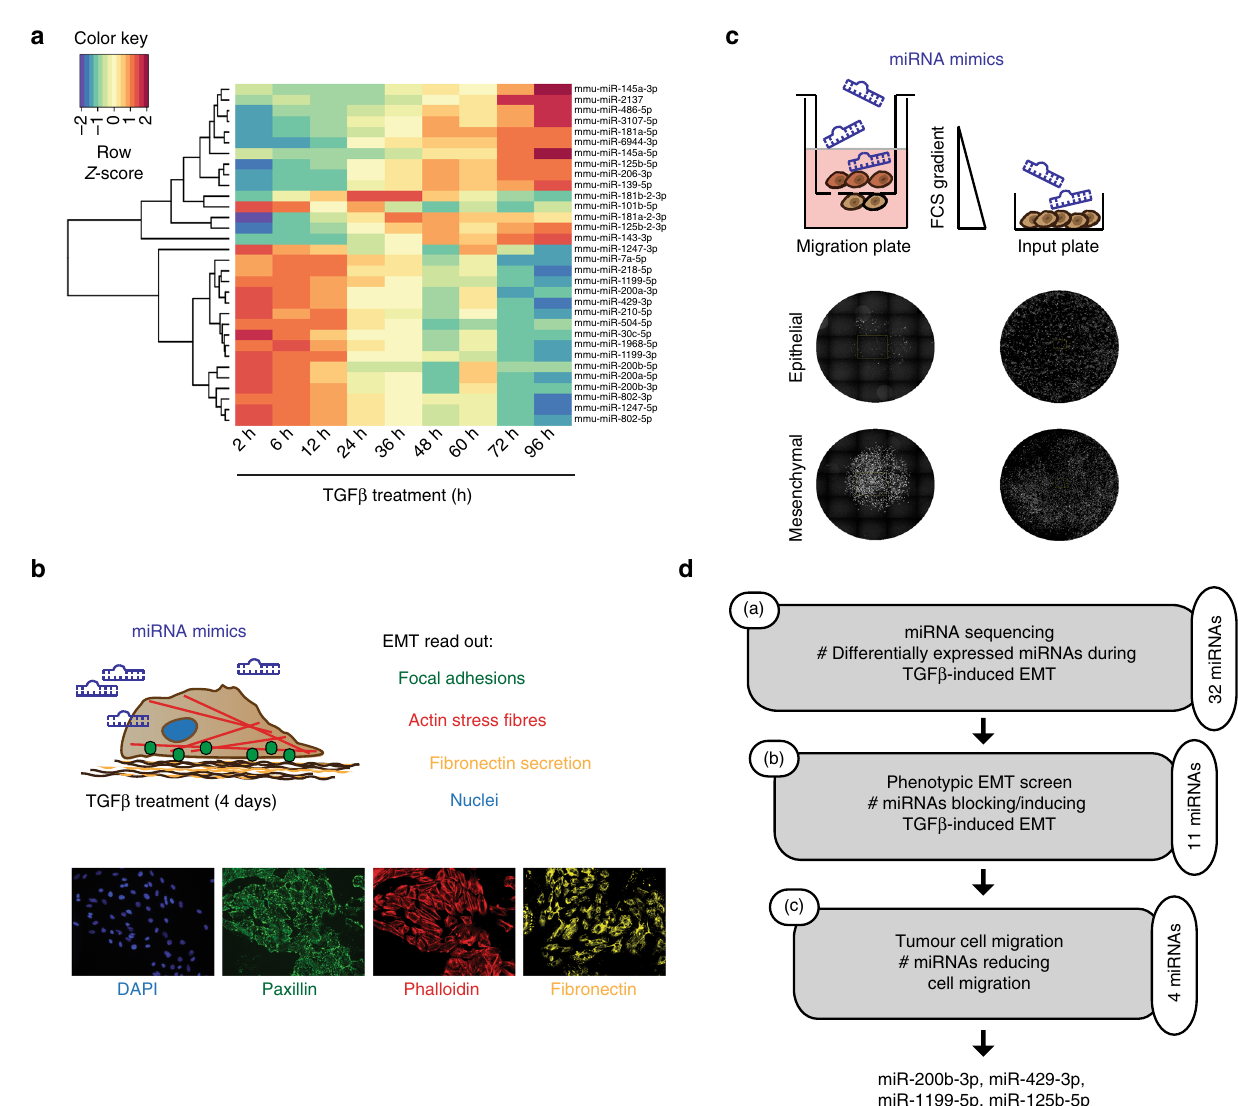
Fig. 1 Identi fi cation of miRNAs critical for an EMT and cell migration. a Expression pro fi ling of miRNAs during a TGF β -induced EMT in NMuMG/E9 cells. NMuMG/E9 cells were treated with TGF β for the time points indicated, and total RNA was isolated for miRNA sequencing. The heat map summarizes the hierarchical clustering of differentially expressed miRNAs (log2FC( ± 2); FDR < 0.05) compared to epithelial, untreated cells during an EMT according to the indicated colour scale. b Identi fi cation of miRNAs controlling EMT. NMuMG/E9 cells were transfected with miRNA mimics for individual miRNAs and analysed for mesenchymal characteristics in the absence and presence of TGF β for 4 days. Formation of focal adhesions (green), actin cytoskeleton reorganization to actin stress fi bres (red), fi bronectin deposition (yellow) and nuclei (blue) were visualized by high-content fl uorescence screening microscopy. c Identi fi cation of miRNAs regulating mesenchymal tumour cell migration. Mesenchymal, migratory Py2T cells ( > 20 days TGF β ) were transfected with different miRNA mimics, plated in 96-well Boyden chamber migration inserts within a FCS gradient and in parallel on a 96-well input plate. Cell nuclei were imaged using a fl uorescence screening microscope and quanti fi ed. Migrated cells were normalized to the total cell number on the input plate. d Scheme depicting the work fl ow and the number of ( a ) differentially expressed miRNAs during an EMT, ( b ) the number of identi fi ed miRNAs functionally contributing to a TGF β -induced EMT and ( c ) the number and names of the miRNAs functionally contributing to mesenchymal tumour